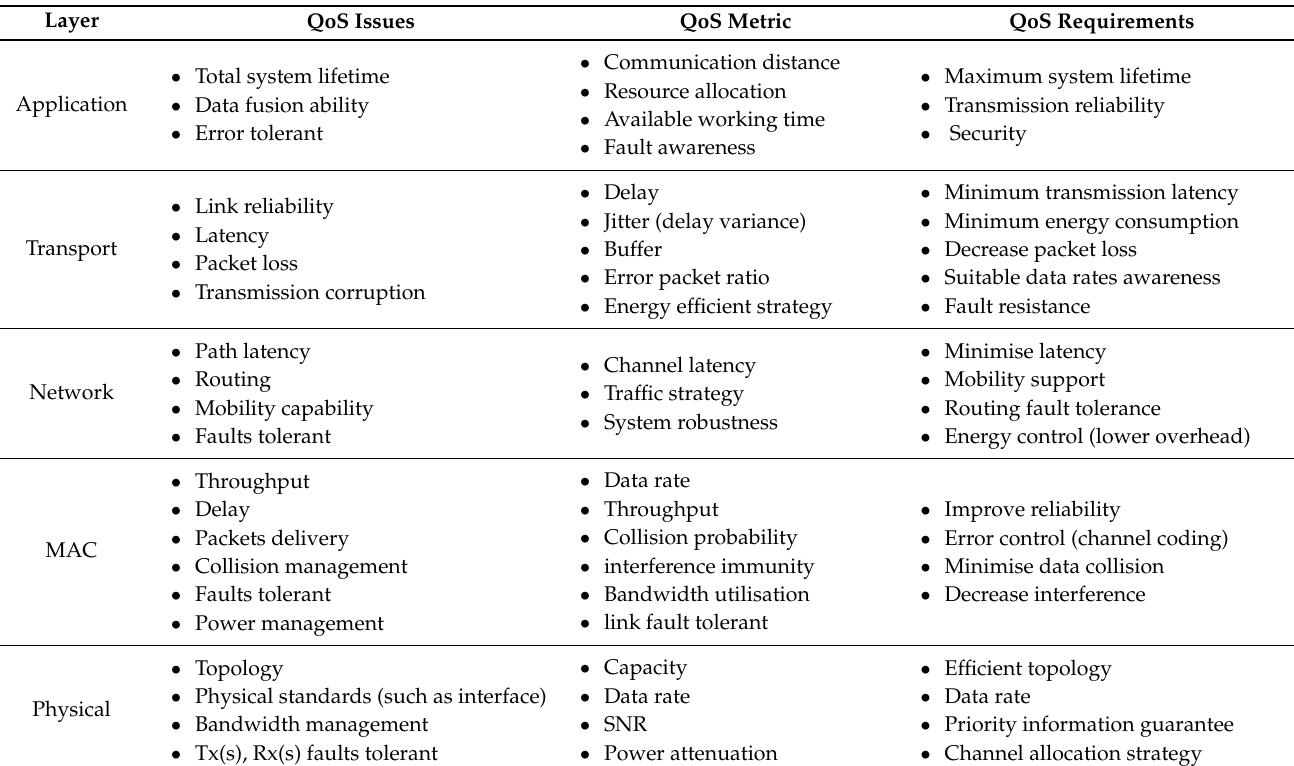
Table 12. Important QoS Parameters of WBAN Service Systems